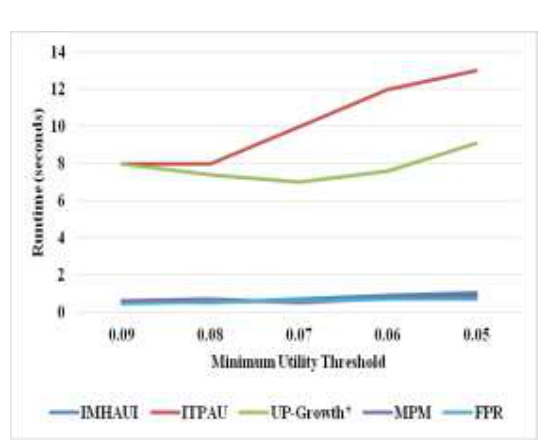
Figure 7. Connect